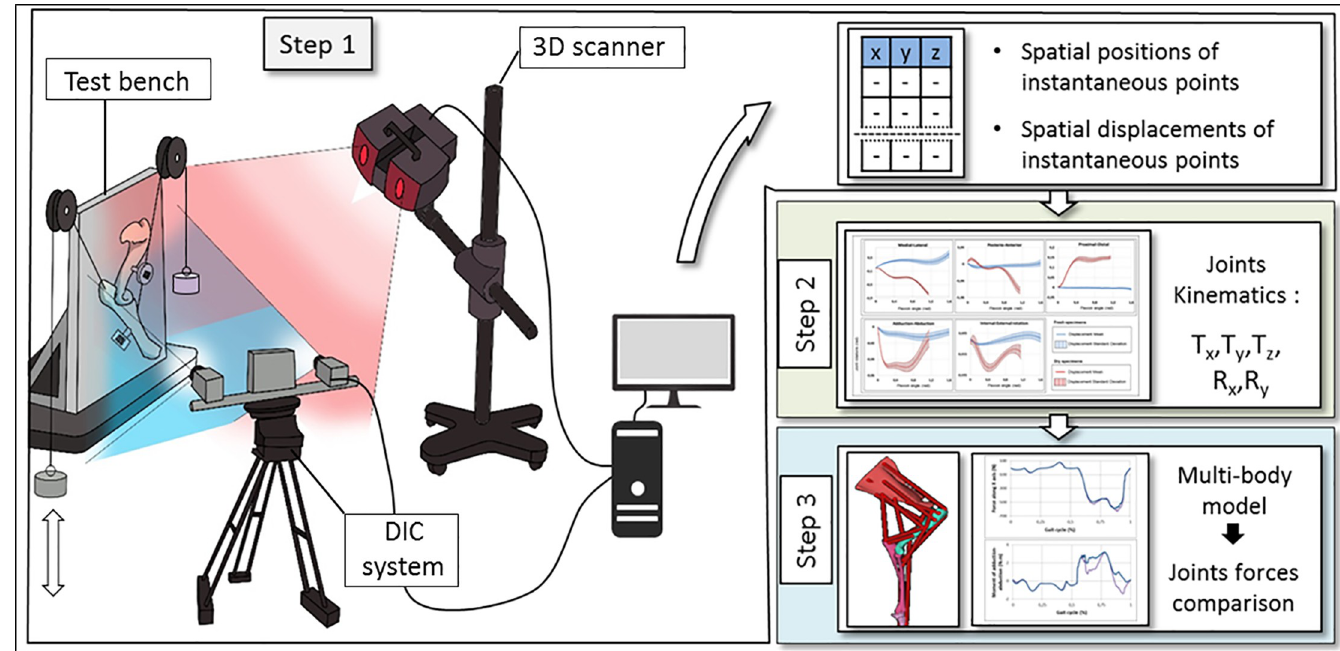
Fig 1. Process for data acquisition and post